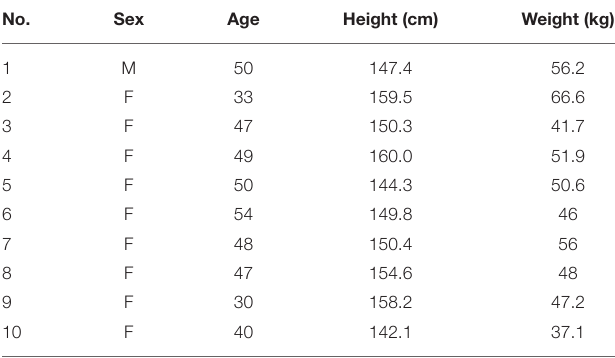
TABLE 1 | Participants’ demographic